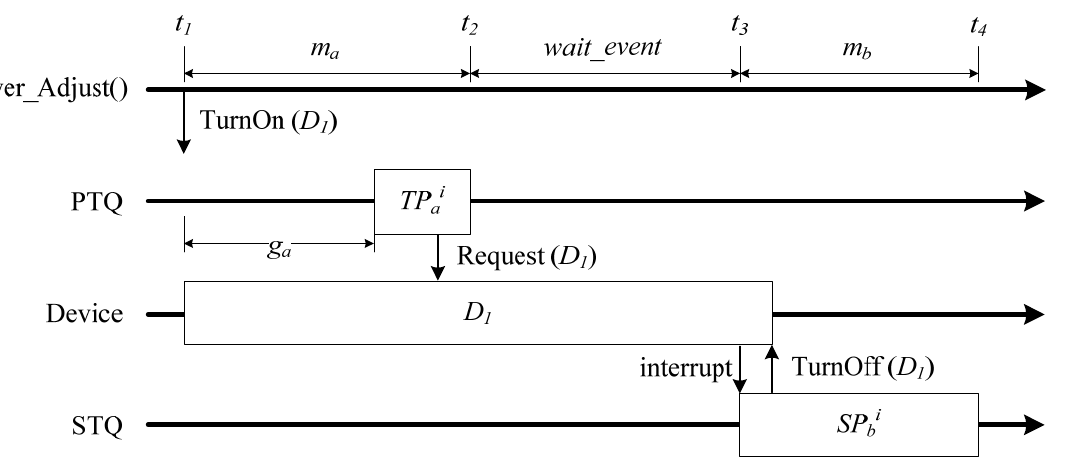
Figure 3. Typical power mode transition